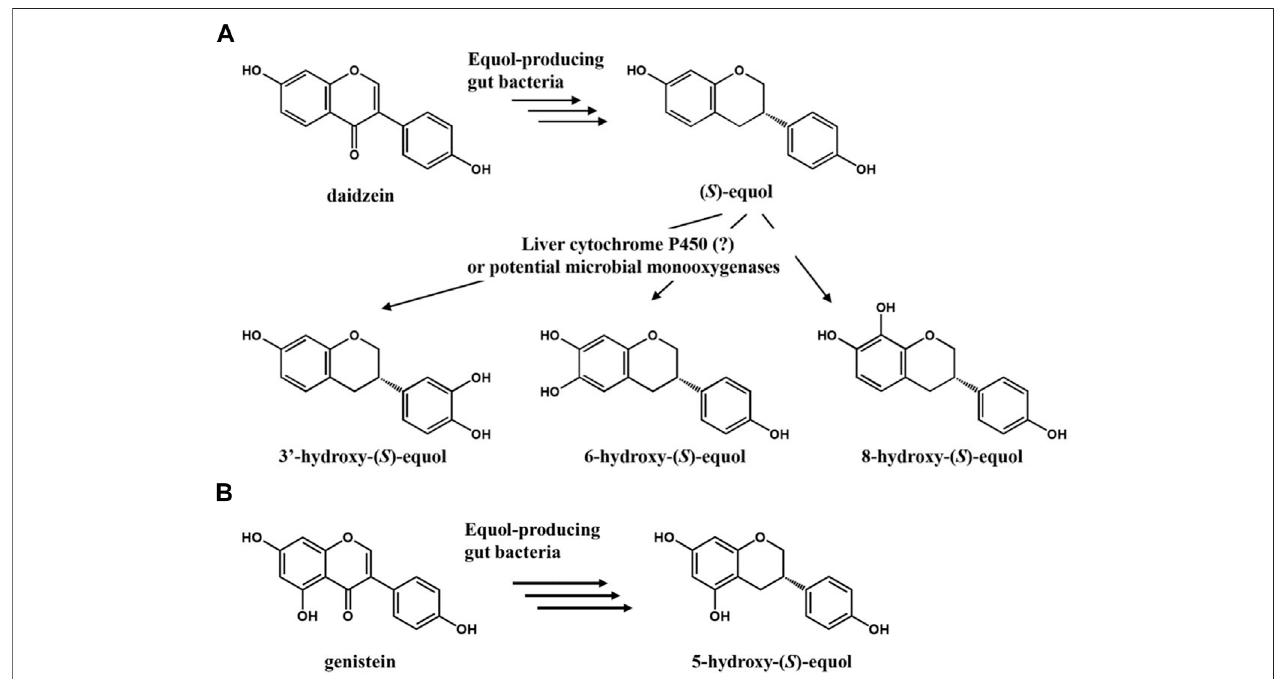
FIGURE1|(A) Potential schemeof( S )-equol hydroxylation after metabolism ofdaidzein into ( S )-equol by gutbacteria. (B) Metabolism ofgenistein into 5-hydroxy- ( S )-equol by gut bacteria.